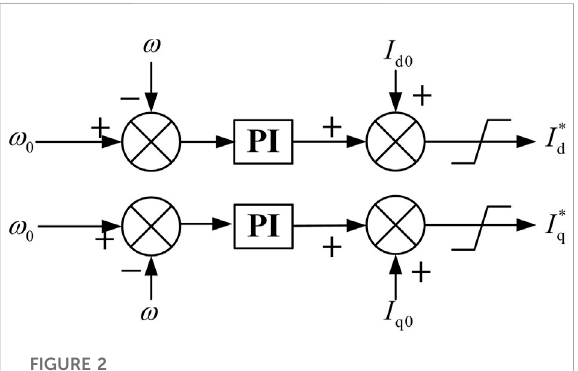
FIGURE 2 Original control model for PV to damp power